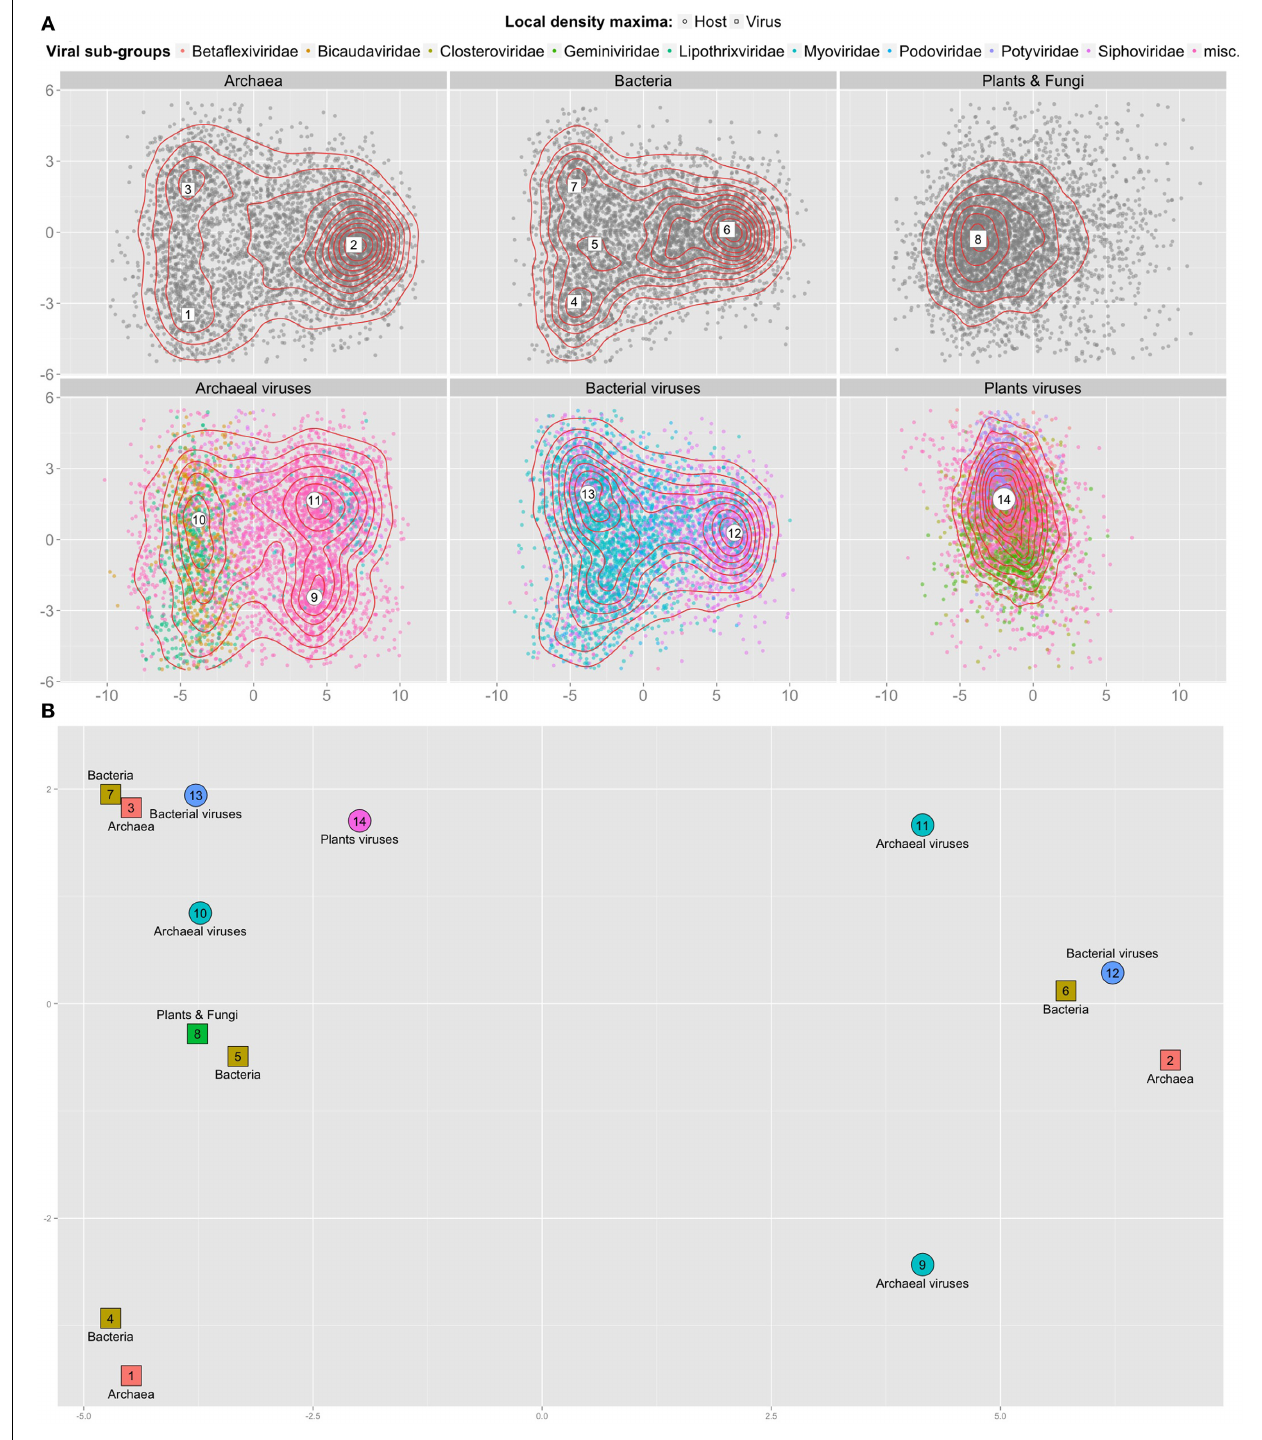
for 8% of the variance. For each sub-panel, 2 d kernel density estimation is represented using red contour lines and local density maxima are numbered within large white shapes. (B) Close up of (A) with all local density maxima. The principal components were computed once for the whole set of contigs of all genomes. Position, coordinates and axes from all sub-panels are